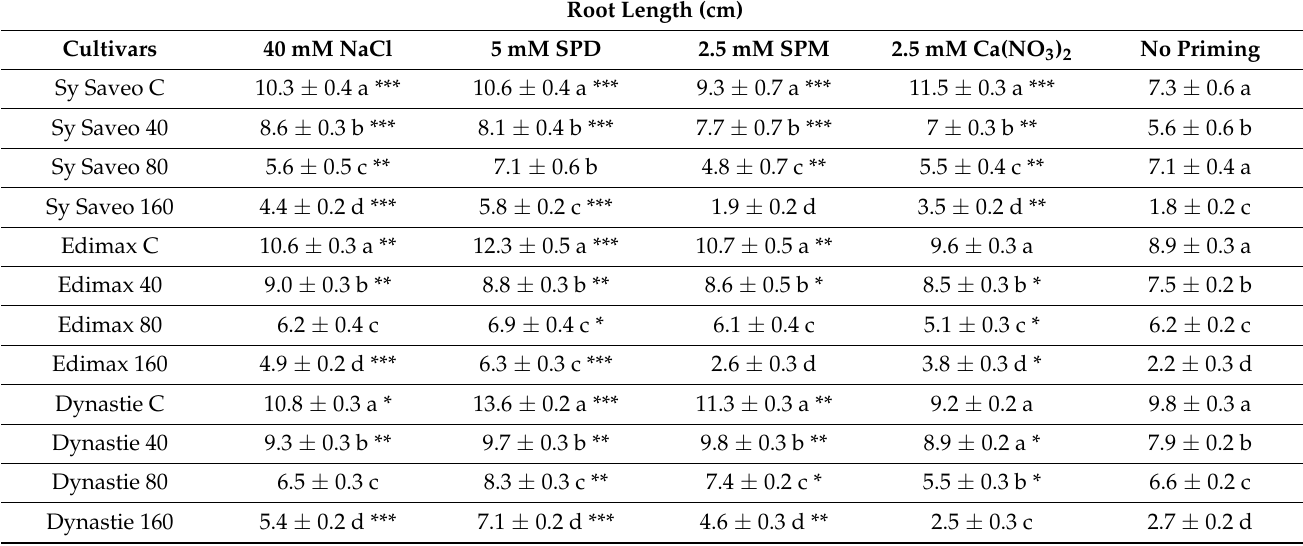
Table 3. Effect of different priming agents on root length (cm) of rapeseed cultivars exposed to different saline conditions: 0 mM NaCl (C), 40 mM NaCl (40), 80 mM NaCl (80), 160 mM NaCl (160). Data are expressed as means ± SE ( n = 8). Mean values in the column marked by different letters are significantly different within the same group ( p ≤ 0.05; ANOVA and Tukey–Kramer test). Significant differences between groups are reported as * p < 0.05; ** p < 0.01; *** p < 0.001.